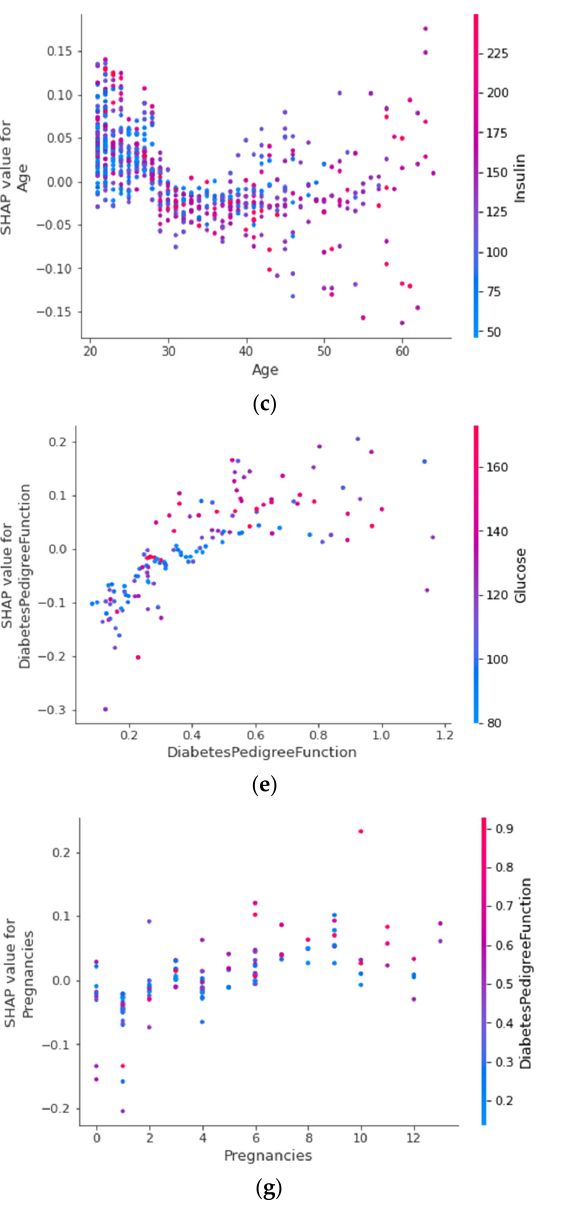
Figure 14. SHAP dependence plot by voting classifier for ( a ) glucose, ( b ) BMI, ( c ) age, ( d ) blood pressure, ( e ) diabetes degree function, ( f ) insulin, ( g ) pregnancies, and ( h ) skin thickness using all folds.